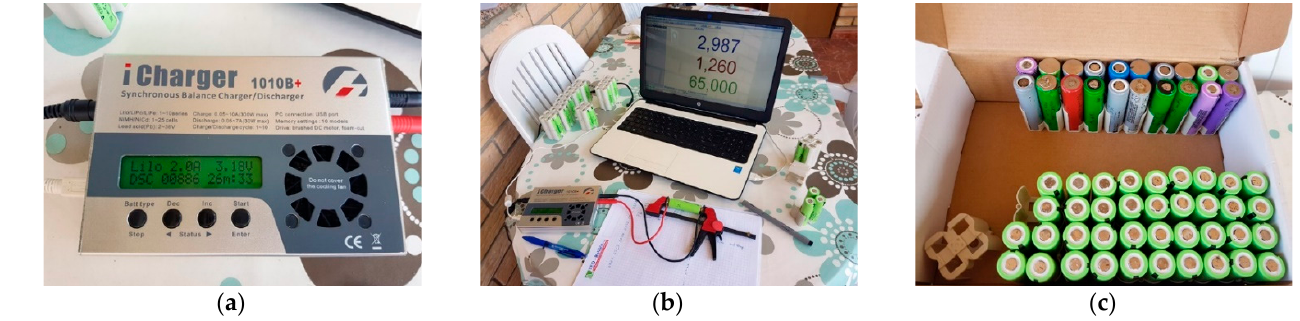
Figure 16. A system charger ( a ); battery cell current clamp ( b ); and disassembled battery pack cells ( c ). Table 2 shows the discharge parameters of all cells that were previously charged to nominal maximum voltage of 4.2 V. The cells were discharged with current of 2 A to voltage of 3 V [41]. That specific value of discharge current is the value closest to finding the maximum capacity under real conditions and also the value expected for the maximum battery load under dynamic operating conditions for an engine at the typical speed shown in Figure 1. According to the technical data [33], the cut-off voltage is 2.50 V, but after reaching the voltage of 3 V, the capacity change is significantly less noticeable, which further confirms the guidelines of [41]. Table 2. Battery pack cell parameter values during 2 A discharge.